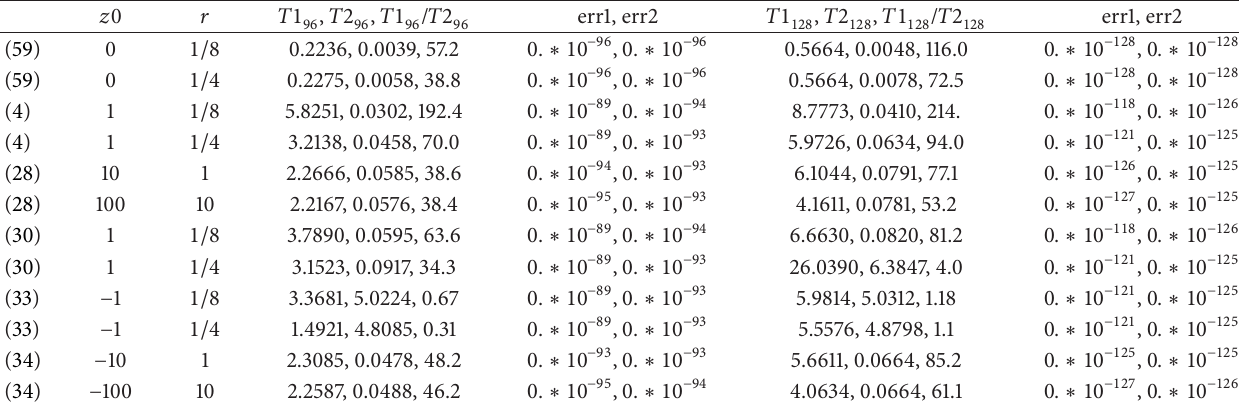
Table 2: Time-consuming comparison of the algorithms (59), (4), (28), (30), (33), and (34) with PolyLog for different precistions ( 𝑛 = 4 , 𝑝 = 5 , and 𝑚 = 16 ). 𝑧